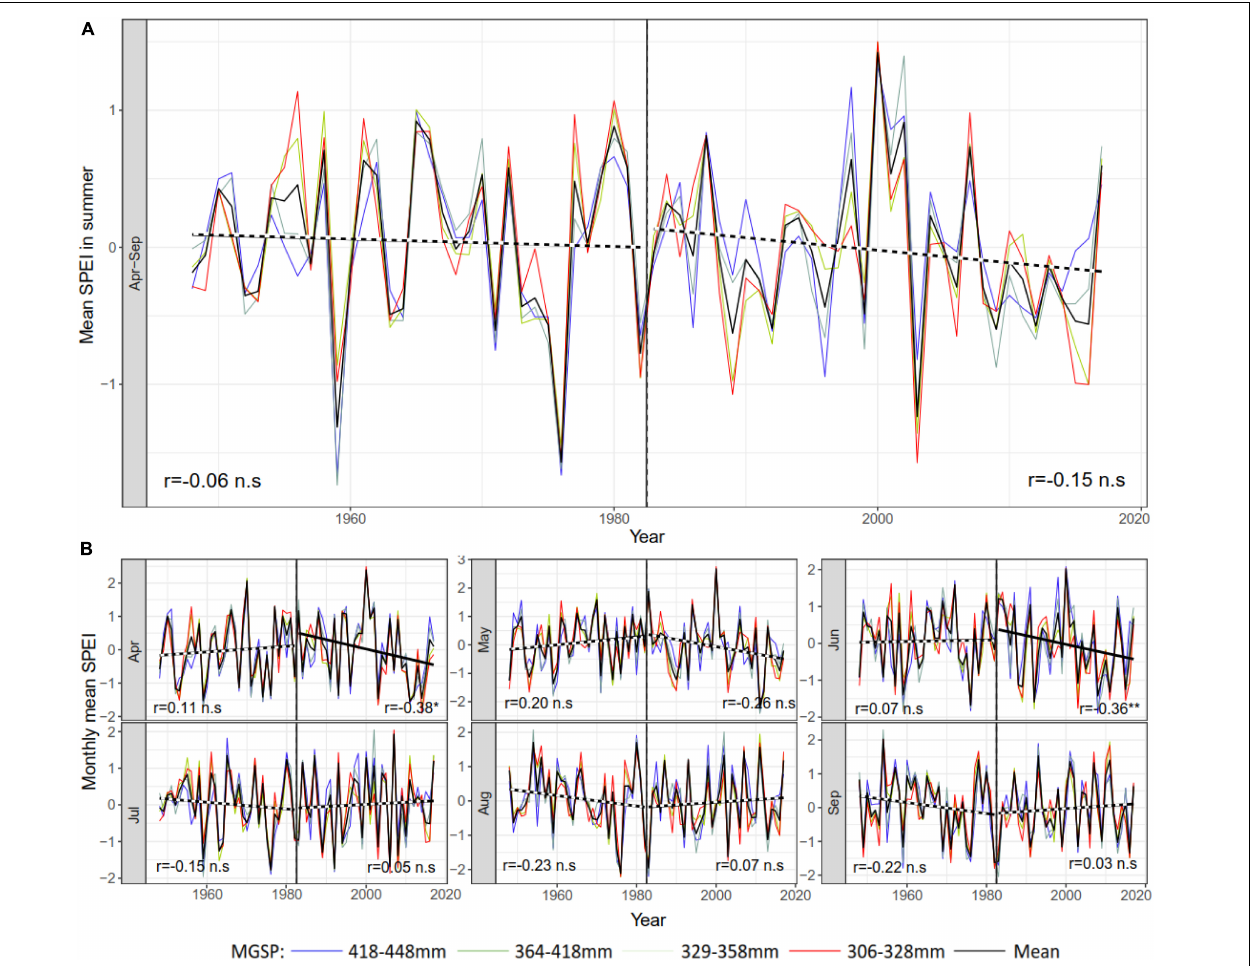
FIGURE 6 | Long-term trends (A) of mean SPEI in summer (Standardized Precipitation Evapotranspiration Index; mean of the months April–September) and (B) of mean SPEI of the individual summer months in the periods 1948–1982 and 1983–2017 extracted from the gridded climate data of the DWD for the 30 study sites in the North German Lowlands, separately displayed for four classes of mean growing season precipitation (April–September; red: driest sites, blue: wettest sites). Significant trends are marked by solid trend lines ( p < 0.05), non-significant ones by dotted trend lines. * p < 0.05, ** p < 0.01 according to a Mann-Kendall trend